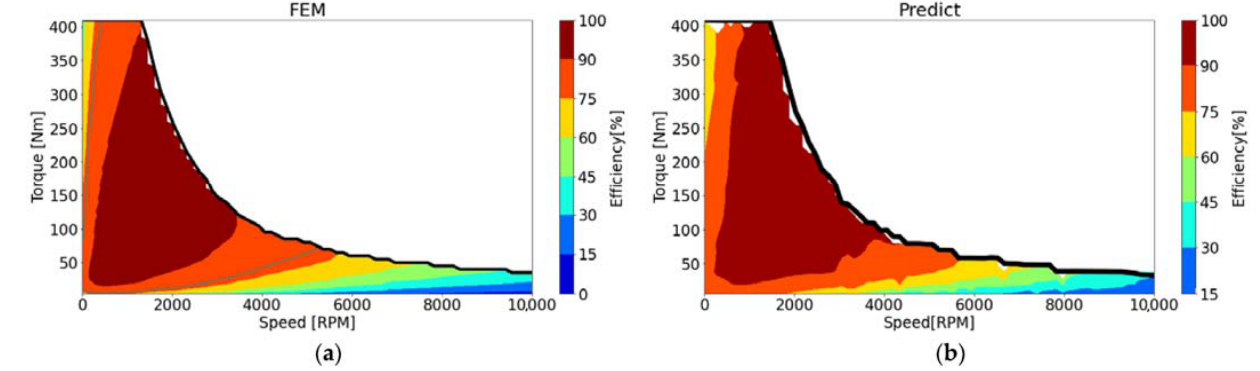
Figure 8. Analyzed motor efficiency: ( a ) 2D FEM; ( b ) proposed method.